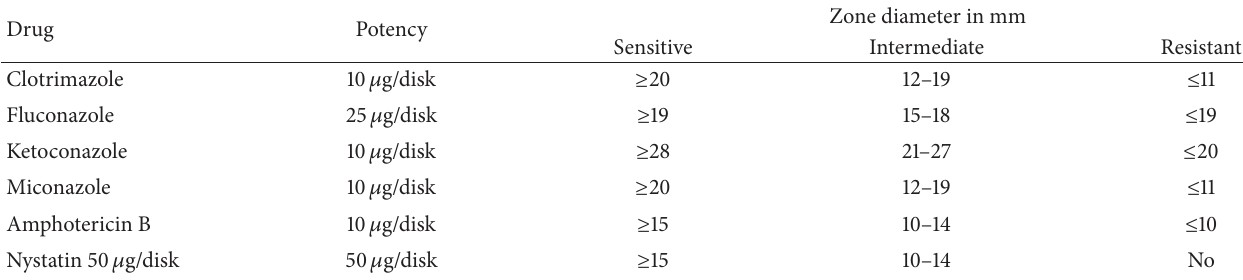
Table 1: Zone diameter interpretation for fungi.